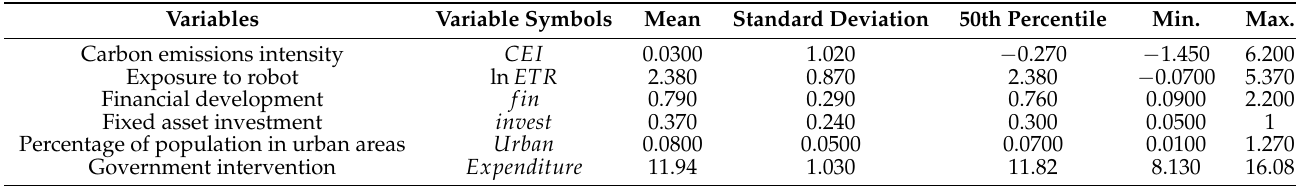
Table 1. Variables and descriptive